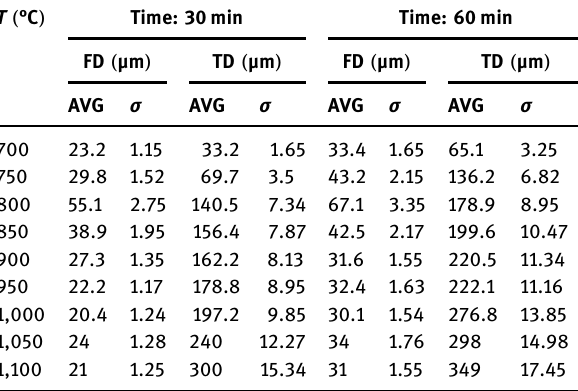
Table 2: Decarburized layer thickness values